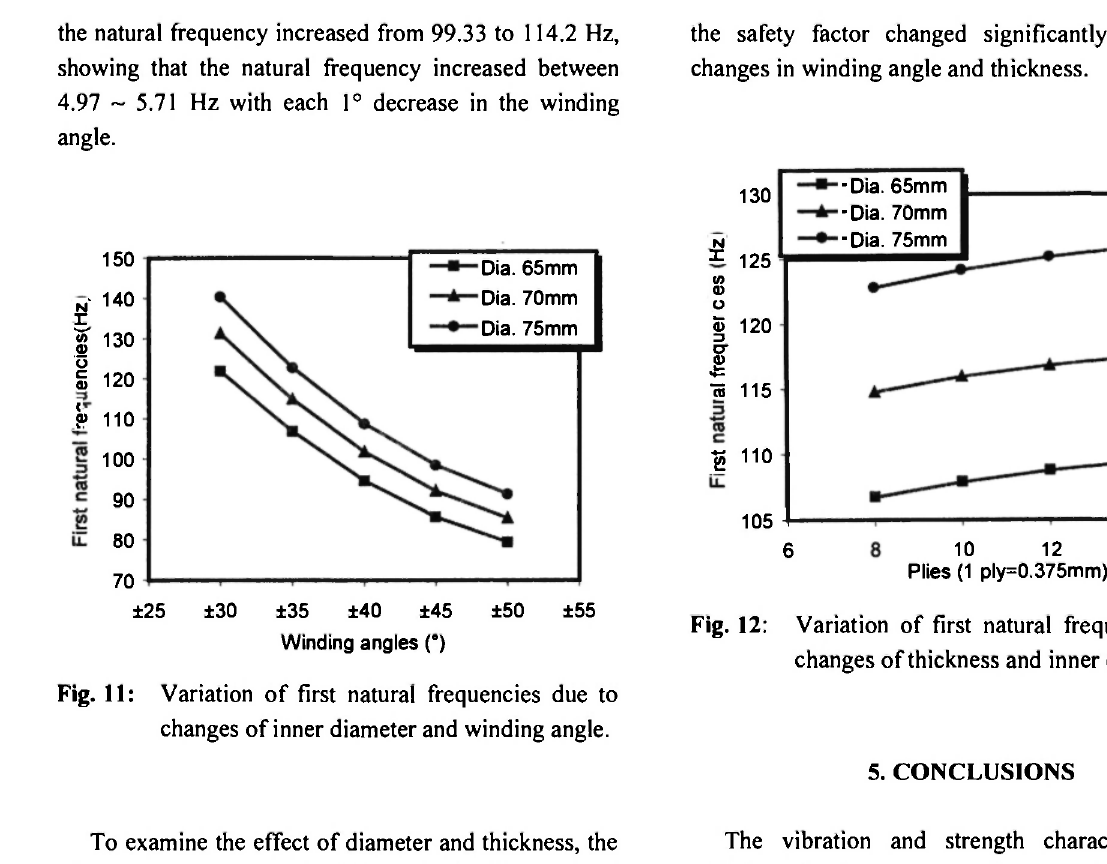
Fig. 11 : Variation of first natural frequencies due to changes of inner diameter and winding